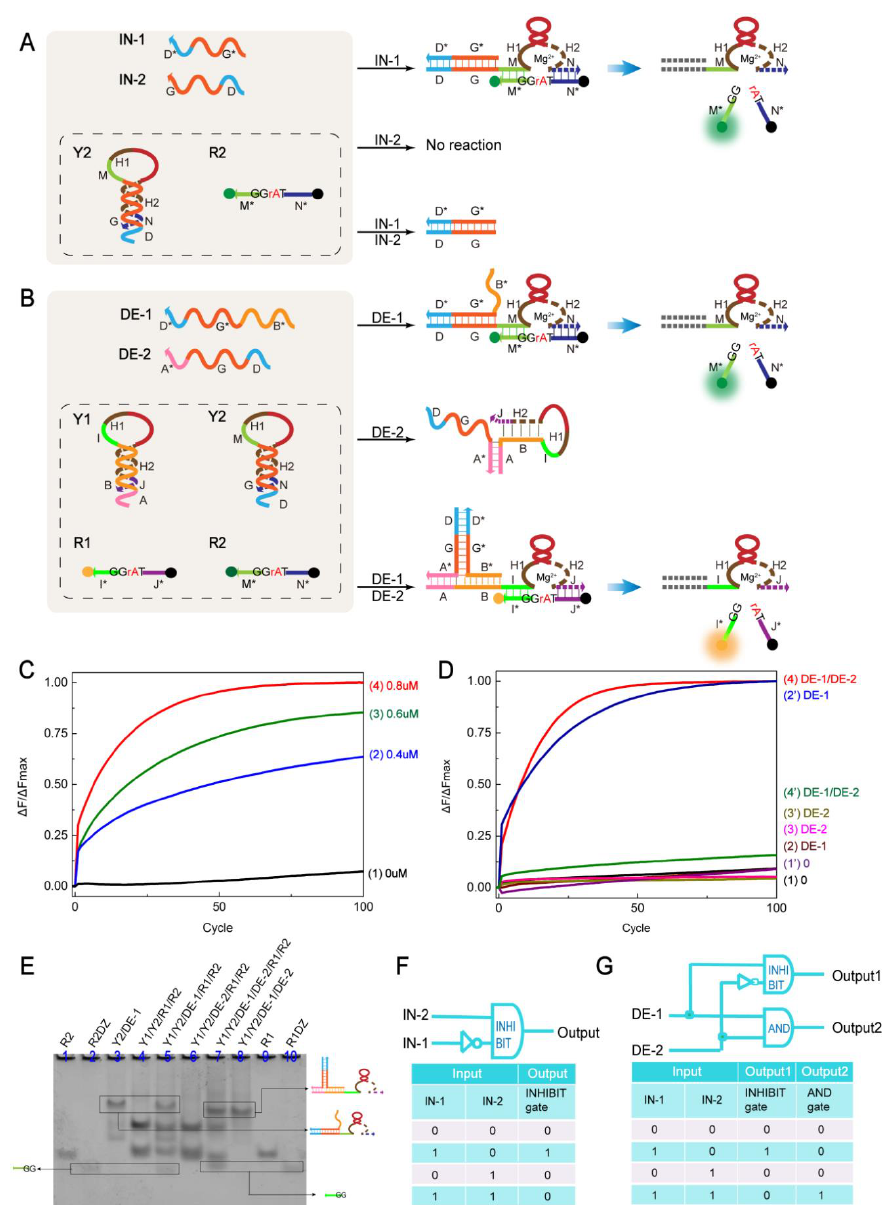
Figure 3. ( A ) Schematic of the INHIBIT logic gate. ( B ) Schematic diagram of the demultiplexer logic circuit. ( C ) Time-dependent normalized fluorescence intensity changes (ΔF/ΔFMax) at different input concentrations. Curves 1, 2, 3, and 4 reflect the fluorescence changes of input strand IN-1 at 0 µM, 0.4 µM, 0.6 µM, and 0.8 µM, respectively. The other strand concentrations in the solution were maintained at 0.3µM. The sampling interval is 3 min, 100 cycles. All data represent the average of three replicates. ( D ) Time-dependent normalized fluorescence intensity change (ΔF/ΔFMax) at different inputs. Curves 1–4 reflect the fluorescence change of the AND gate of the demultiplexer logic circuit at different inputs. Curve 1′–4′ reflect the fluorescence change of the INHIBIT gate of the demultiplexer logic circuit at di ff erent inputs. The sampling interval is 3 min, 100 cycles. All data represent the average of three replicates. ( E ) Gel analysis of the YES gate reaction using 12% PAGE. Lane 1: R2; Lane 2: R2DZ; Lane 3: Y2 and DE-1; Lane 4: Y1, Y2, R1, and R2; Lane 5: Y1, Y2, DE-1, R1, and R2; Lane 6: Y1, Y2, DE-2, R1, and R2; Lane 7: Y1, Y2, DE-1, DE-2, R1, and R2; Lane 8: Y1, DE-1, and DE-2; Lane 9: R1; Lane 10: R1DZ. Note that since the R1 and R2 sequences are too short to appear easily on the PAGE diagram, the base T is added to extend the sequence without a ff ecting the experimental results. ( F ) INHIBIT gate logic symbol and truth table. ( G ) Demultiplexer logic circuit symbol and truth